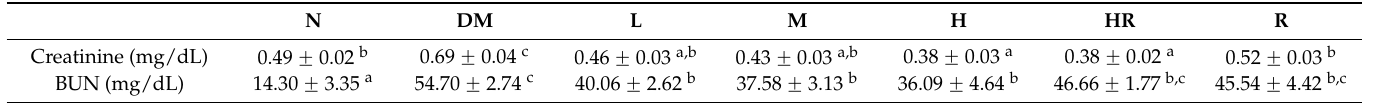
Table 2. Influence of red guava on creatinine and blood urea nitrogen (BUN).